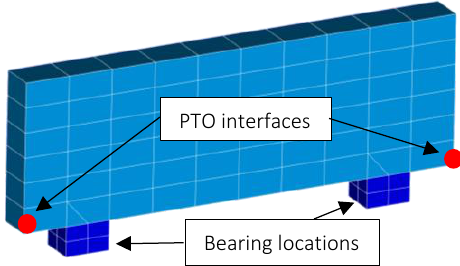
Fig. 5. Schematic of the uncoupled "post-processing"